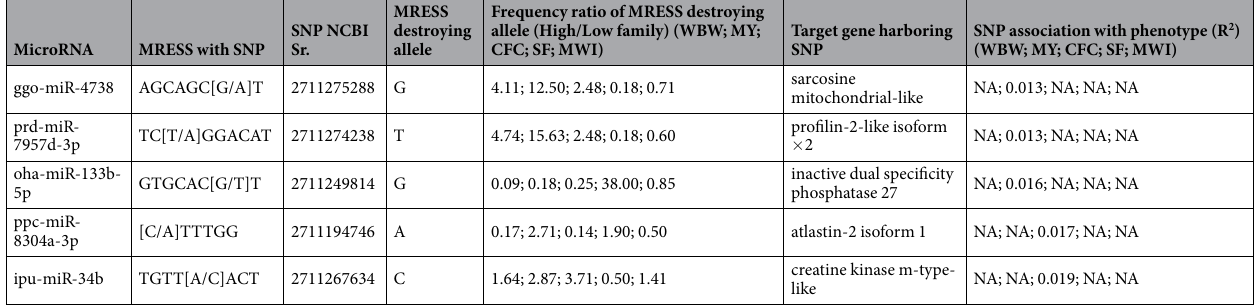
Table 5. SNPs in microRNA recognition element seed site (MRESS) of target gene, allele frequency ratio of MRESS-destroying SNPs between high vs low ranked families of different muscle traits, and correlation between the SNP and phenotype. Column 1 shows potential regulatory microRNA and column 2 shows microRNA binding site in 3 ′ UTR of target gene. Note that only MRESS with SNP, not full microRNA sequence is shown. Complete datasets are given in Supplementary Dataset 5. Note: WBW: whole body weight, MY: muscle yield of WBW (%), CF: muscle crude fat content (%), SF: muscle shear force; and MWI: muscle whiteness